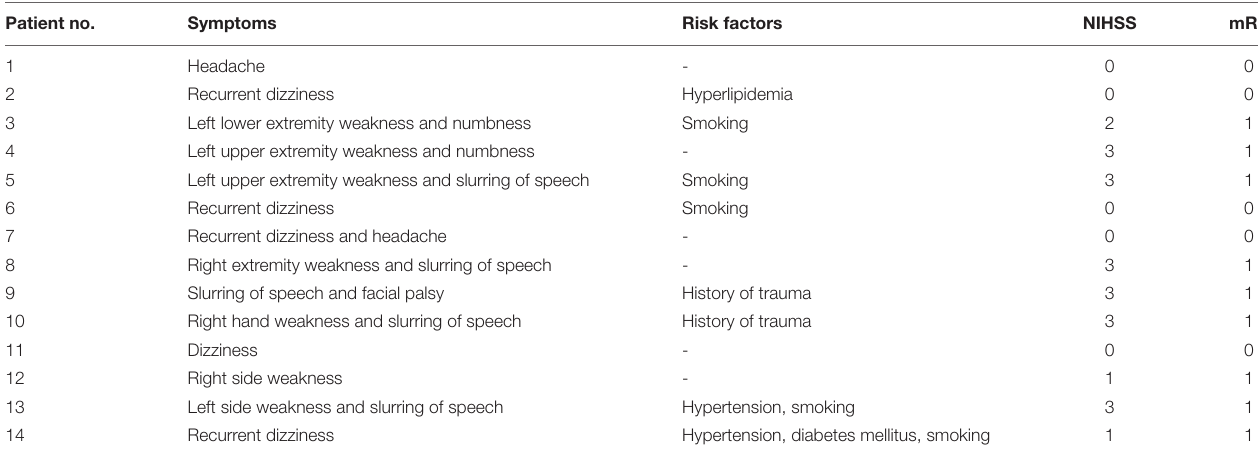
FIGURE 3 | Spiral intramural hematoma in the patient with vertebral artery dissection. Digital subtraction angiography (DSA) showed irregularly mild stenosis without any dissecting signs on anteroposterior and lateral projections ( A,B , arrow). T1-weighted HRMRI showed an spiral intramural hematoma in the right vertebral artery in the coronal ( C , arrow) and transverse planes ( D , arrow). TABLE 1 | Clinical characteristics of the patients with cervical artery dissection. Patient